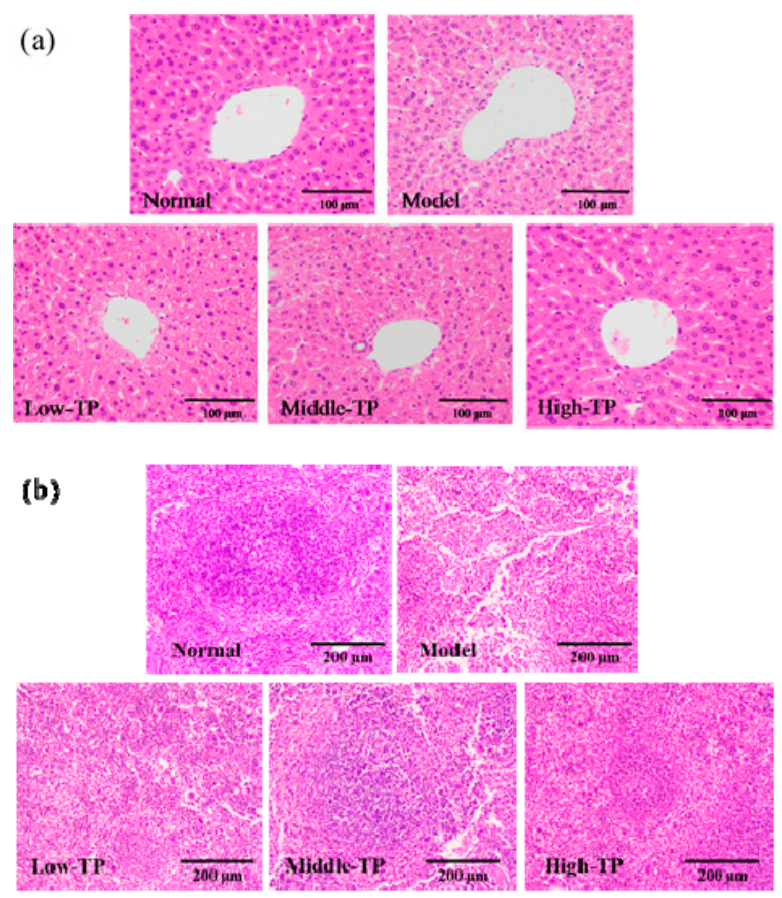
Figure 3. Histopathology observation of liver ( a ) 200× magnification) and Spleen ( b ) 100× magnification.